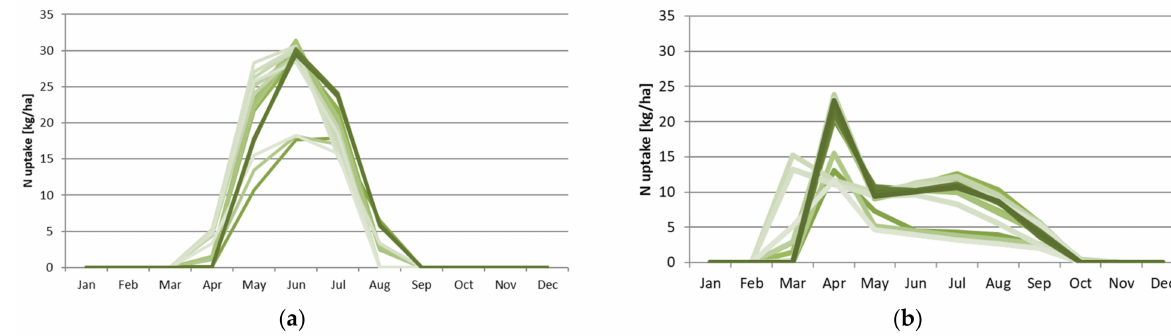
Figure 8. Nitrogen uptake of ( a ) spring cereals, ( b ) forest on moist soil. Baseline is presented by the darkest